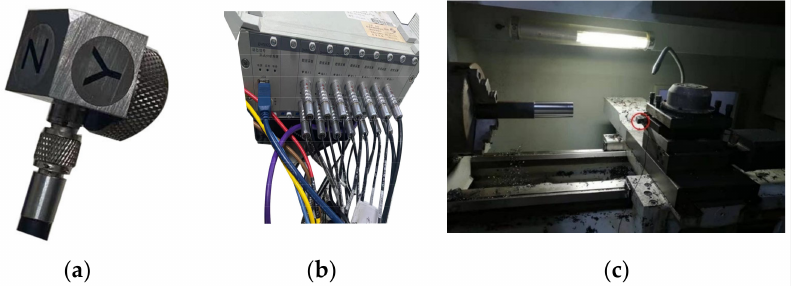
Figure 2. ( a ) 1A313 type acceleration sensor; ( b ) DH5922 signal acquisition instrument; ( c ) placement of